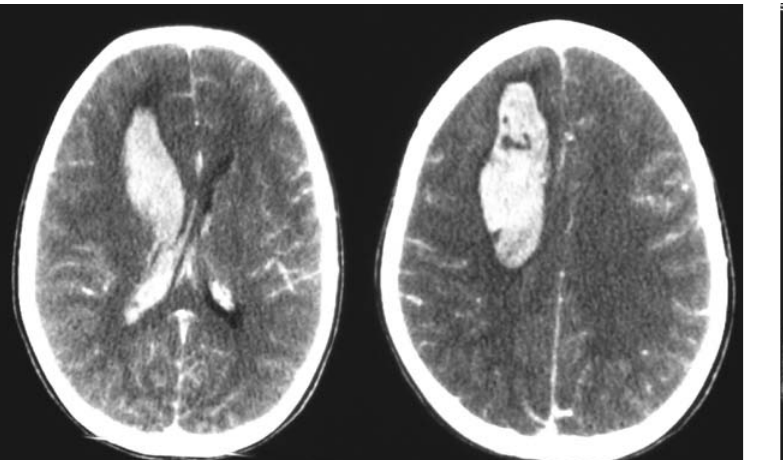
Right sylvian AVM. left: Conventional angiogram revealing a right sylvian AVM fed by numerous small lateral branches. Right: Angio-MRi of the AVM.The haemor- rhage is visualised, and partially masks the nidus of the